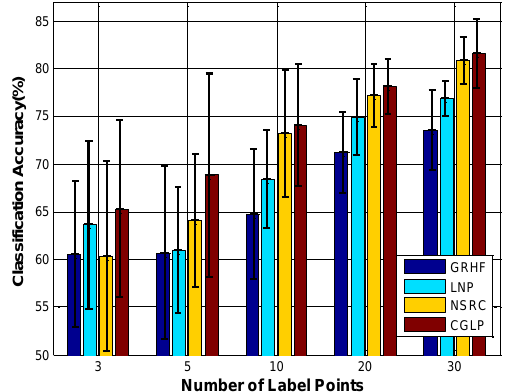
Figure 2 Classification results by different methods over Classes 4 and Classes 5 of KSC data